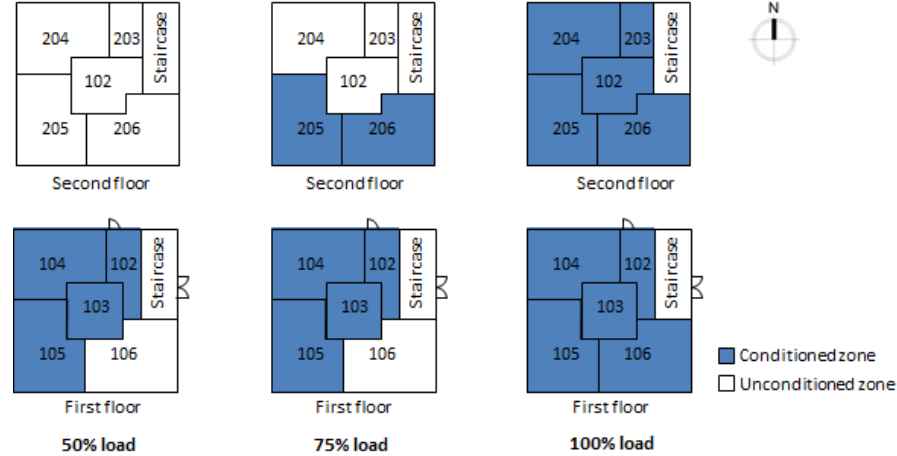
Figure 8. Schematic of operation to emulate.